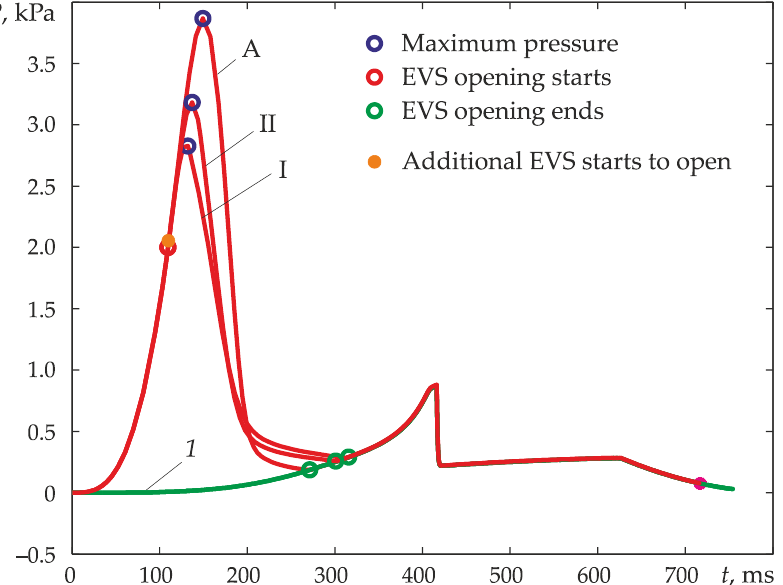
Figure 11. Excessive pressure of an explosion inside a kitchen: ( А ) non-upgraded EVS; I — additional opening is covered with an EVS with a response rate of 0.05 kPa; II — additional opening is covered with an EVS with a response rate of 0.125 kPa; 1 — explosive pressure inside the kitchen with a fully open window area.